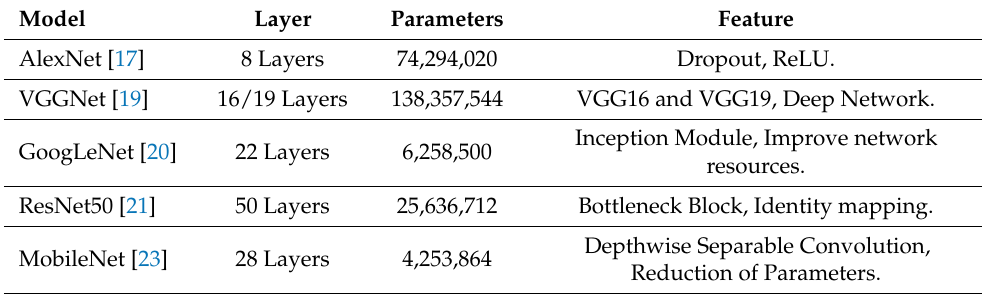
Table 2. The comparsion of different CNN